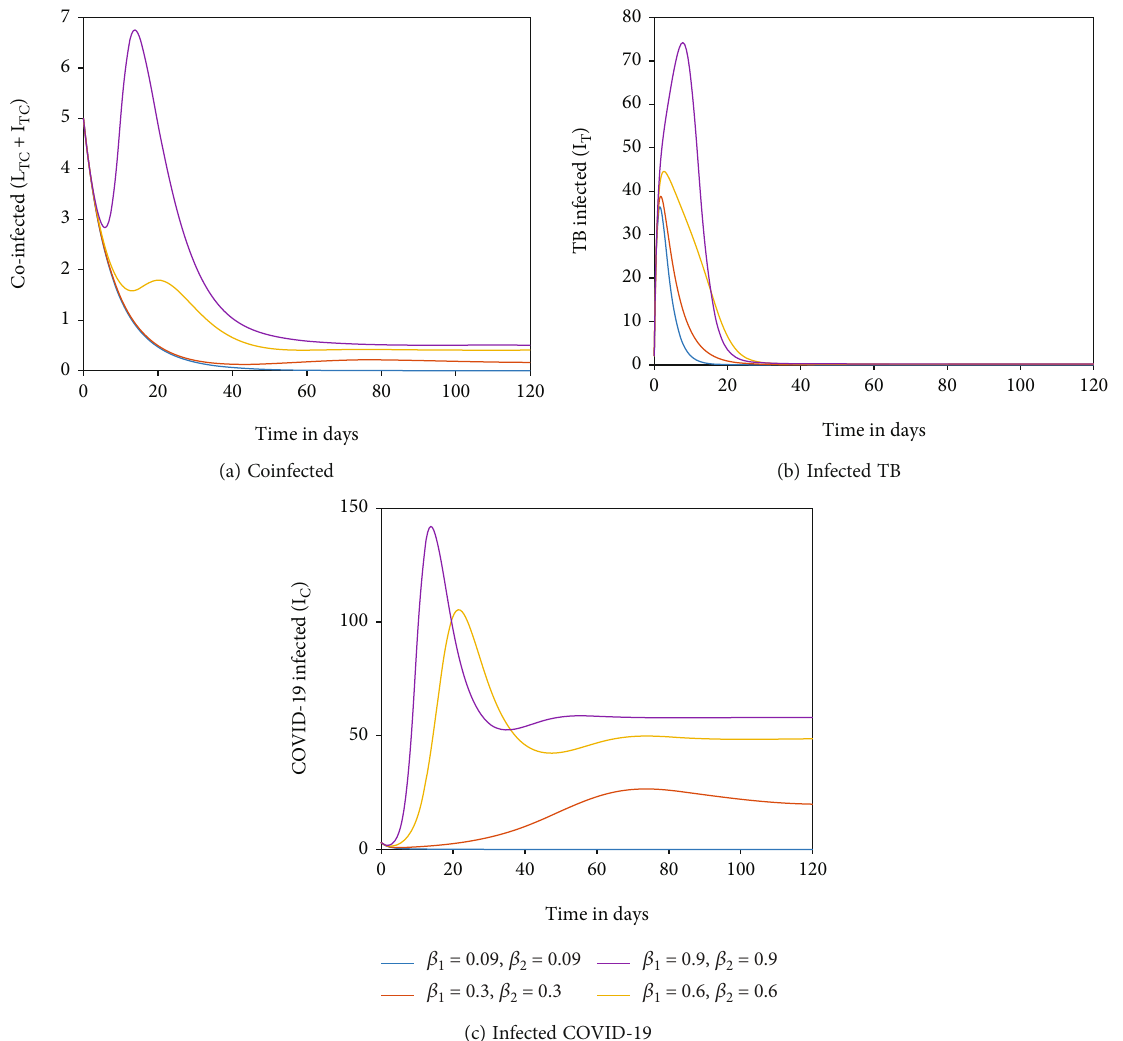
β 1 and 2 on the transmission dynamics of TB (